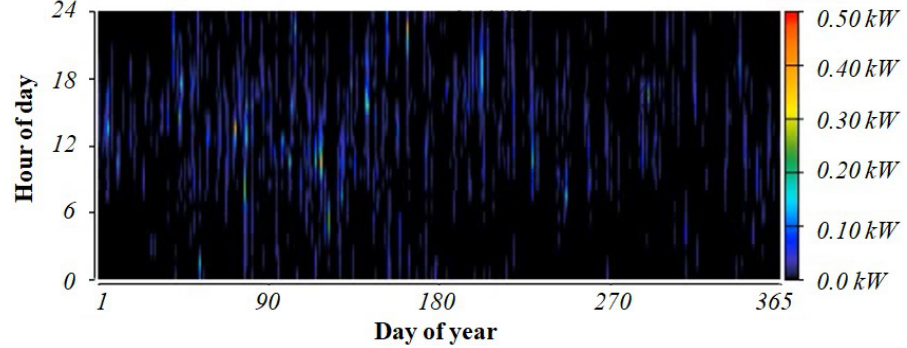
Figure 15. Yearly power output from wind turbine for PV-Wind-BSS-DG configuration.